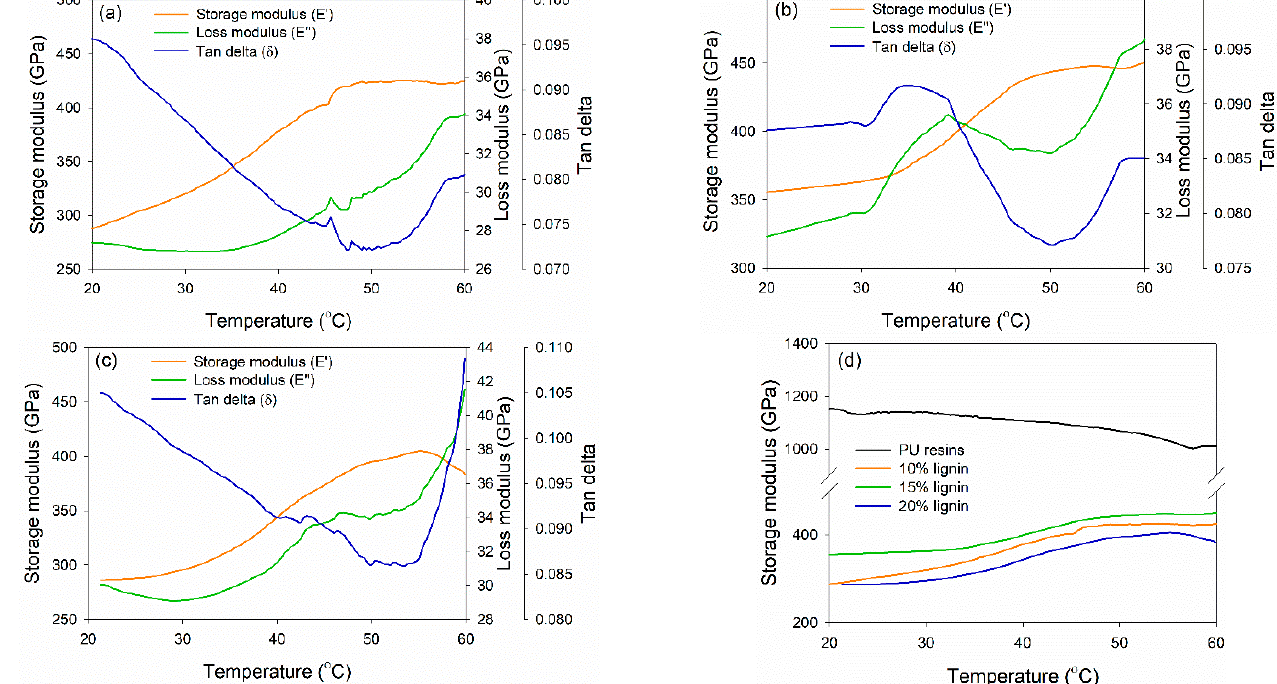
Figure 6. Dynamic mechanical analysis of PVOH–lignin–hexamine blends at different contents of lignin: ( a ) 10% lignin, ( b ) 15% lignin, ( c ) 20% lignin, ( d ) storage modulus of control PU resins and PVOH–lignin–hexamine-based adhesives.